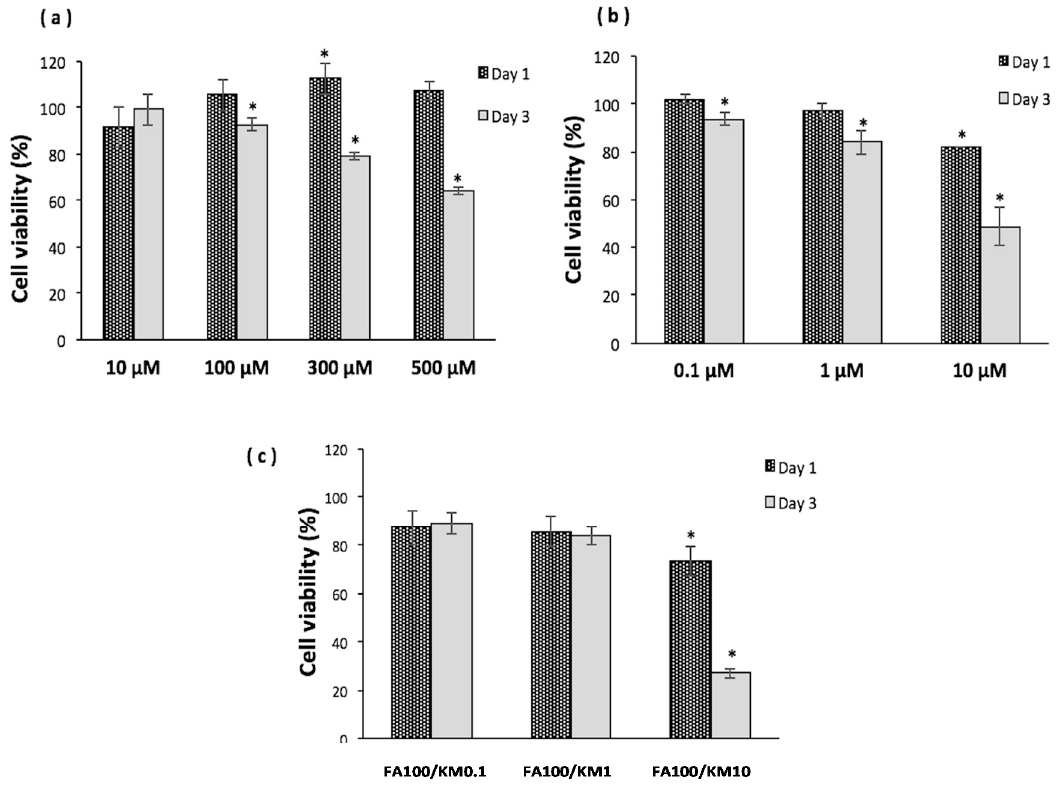
Figure 1. Cell viability of human corneal epithelial cells (HCECs) after incubation with varying concentrations of ( a ) ferulic acid (FA), ( b ) kaempferol (KM) and ( c ) a FA/KM mixture for one or three days. Data were analyzed using the paired t-test and are expressed as the mean ± standard deviation (SD); n = 6, (* p < 0.05 compared with the control group). FA100: 100 µ M FA; KM1: 1 µ M KM; KM0.1: 0.1 µ M KM.